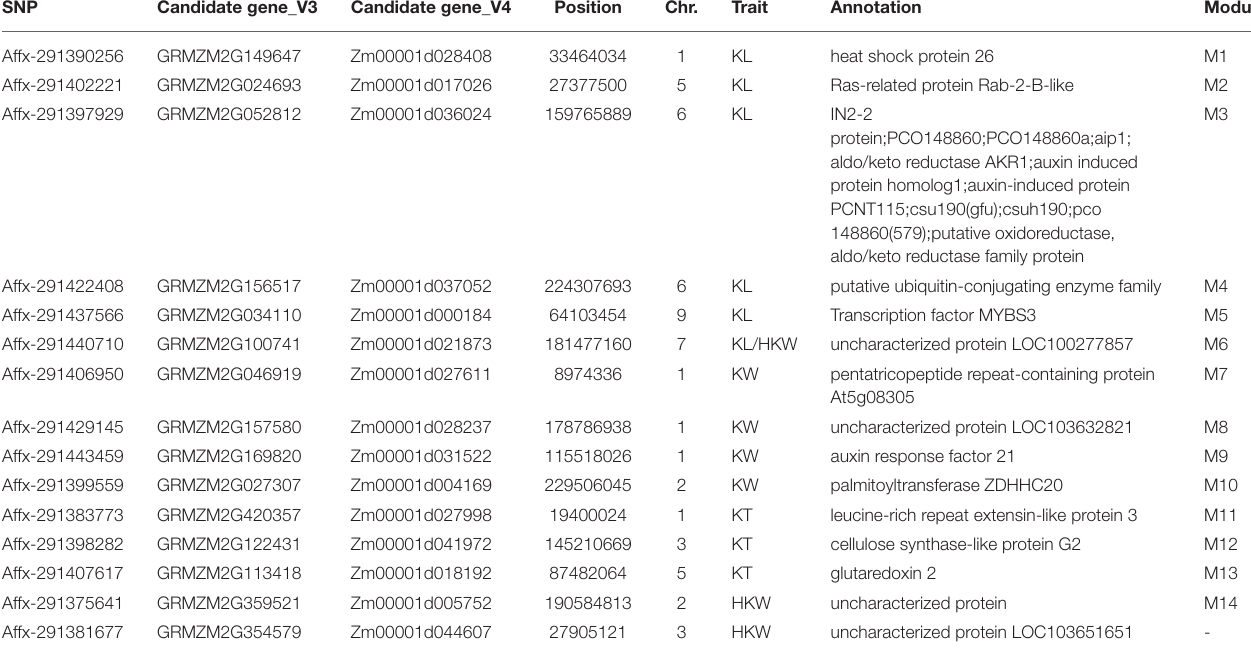
Module indicate the protein-protein interaction network of the proteins encoded by candidate genes. KL, kernel length; KW, kernel width; KT, kernel thickness; HKW, hundred-kernel weight; Chr.,